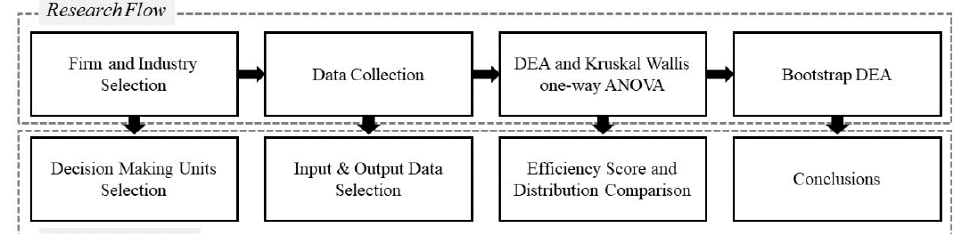
Figure 2. Research flowchart.